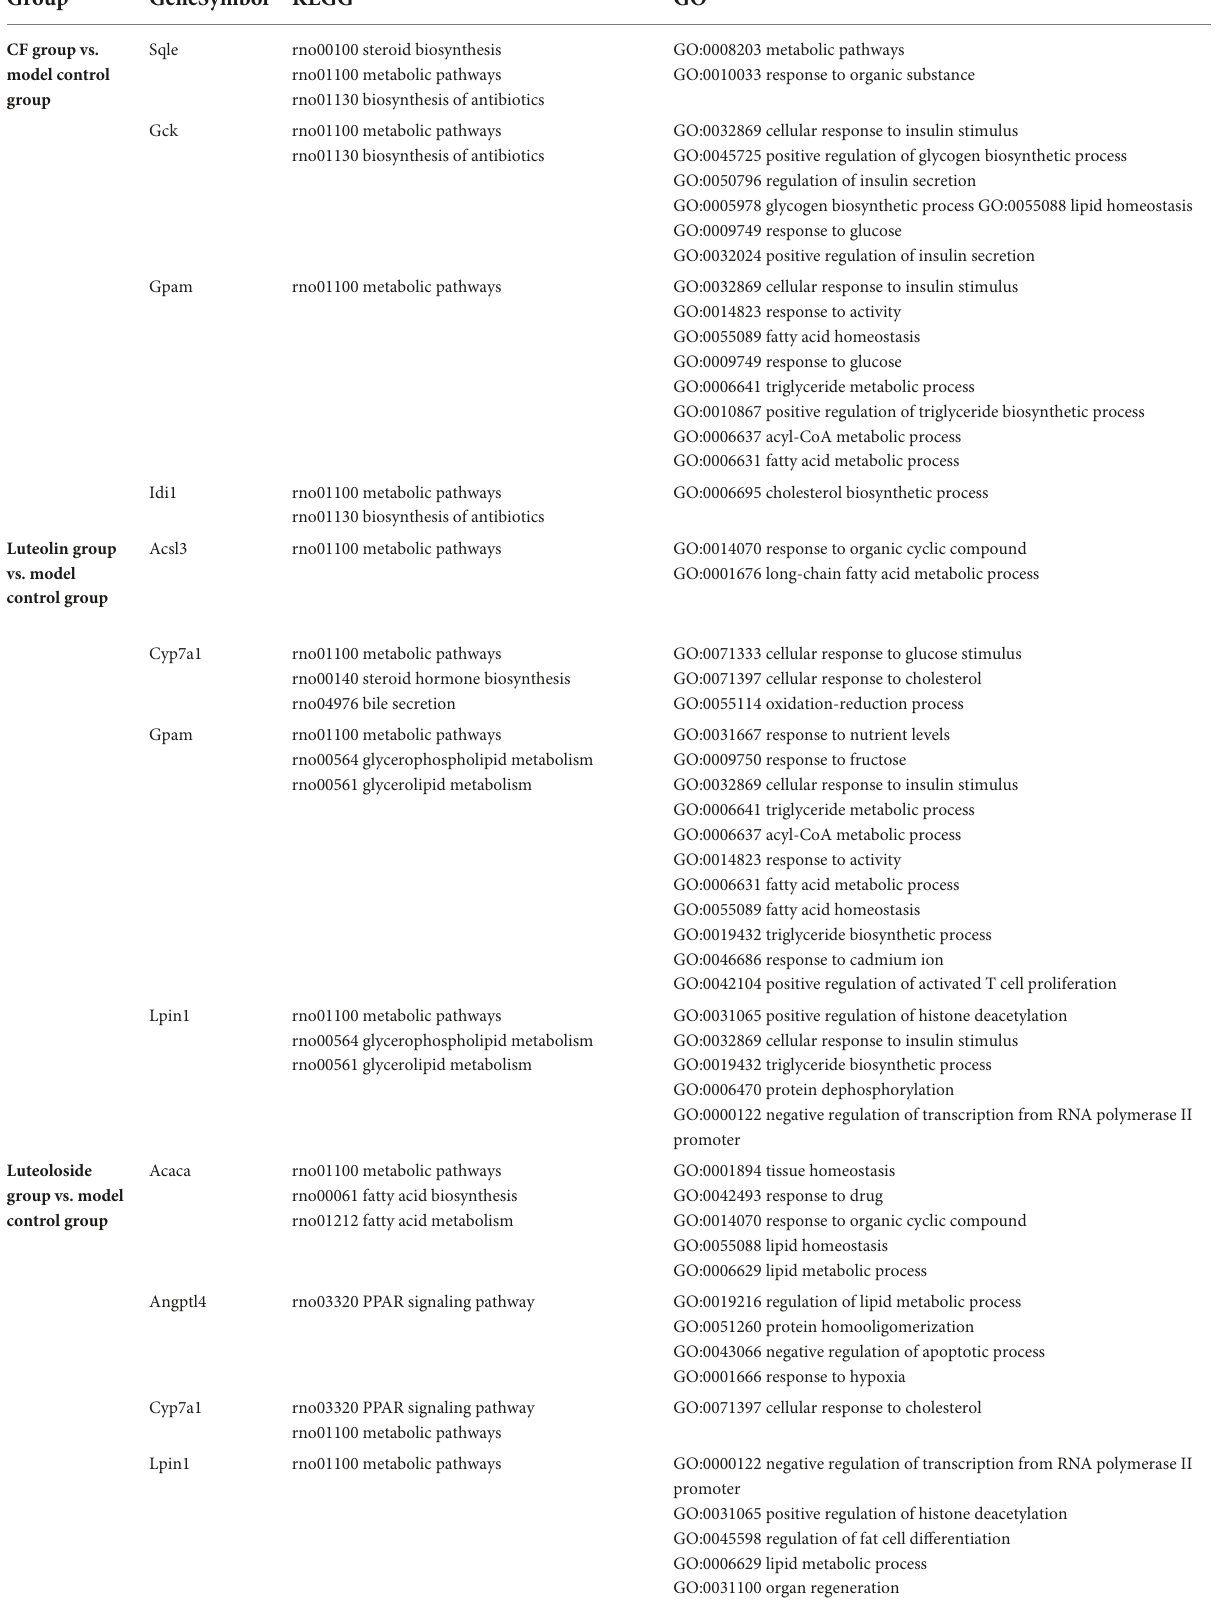
TABLE 3 Differential genes both significantly enriched in KEGG and GO biological process